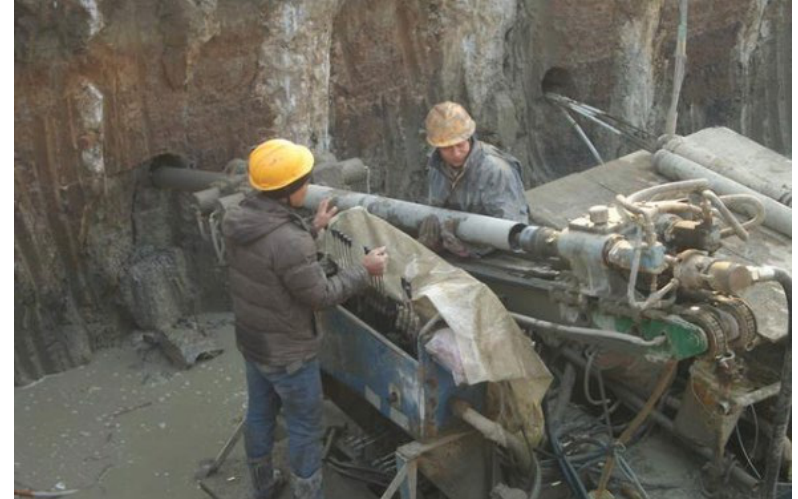
Figure 3. Drilling construction of anchor cable.